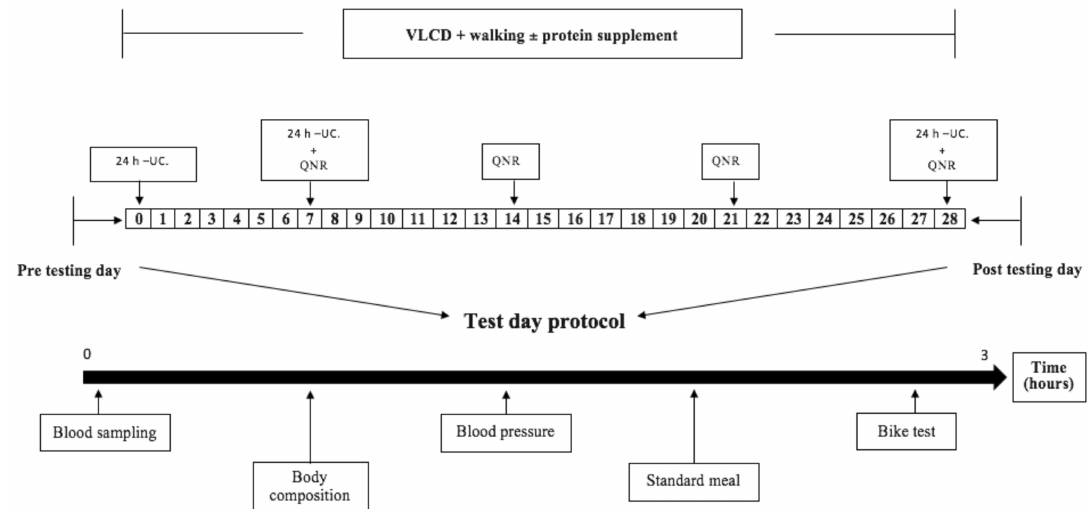
Figure 1. Overview of the design. The pre- and post-tests were performed maximally five days after the intervention. 24h-UC: 24-h urine collection. QNR: questionnaires. VLCD: very low caloric diet. Body composition: dual-energy X-ray absorptiometry (DXA) scan and hip and waist circumference measurements. Bike test: Aastrand 2–point bike test.